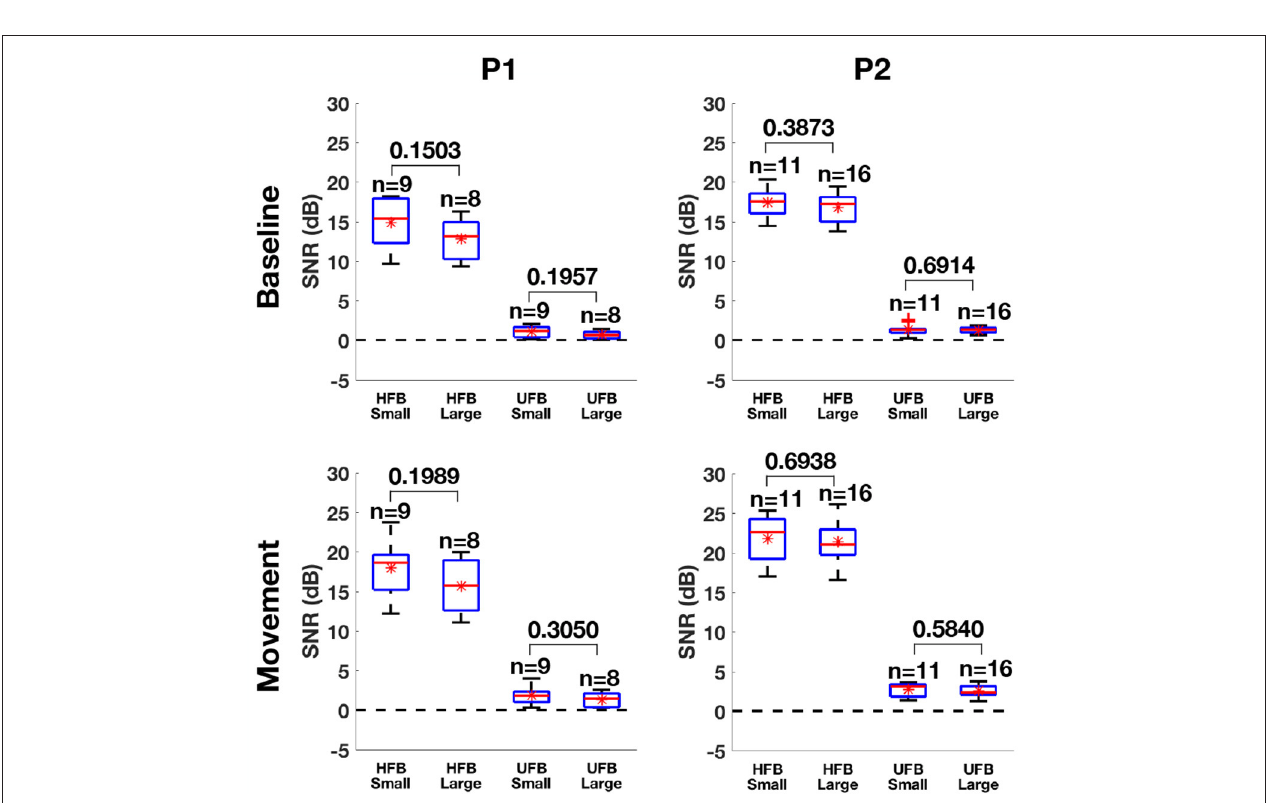
FIGURE 11 | The boxplots of SNR in HFB and UFB between small and large contacts for P1 (left) and P2 (right) computed from baseline (upper) and movement (bottom). The sample number of each group is displayed above the corresponding box. The p -value of two-tailed Student’s t -test between small and large contacts is also shown. Red star denotes the mean value while the red band within the box denotes the median. The noise floor (0 dB) is represented by the horizontal dash